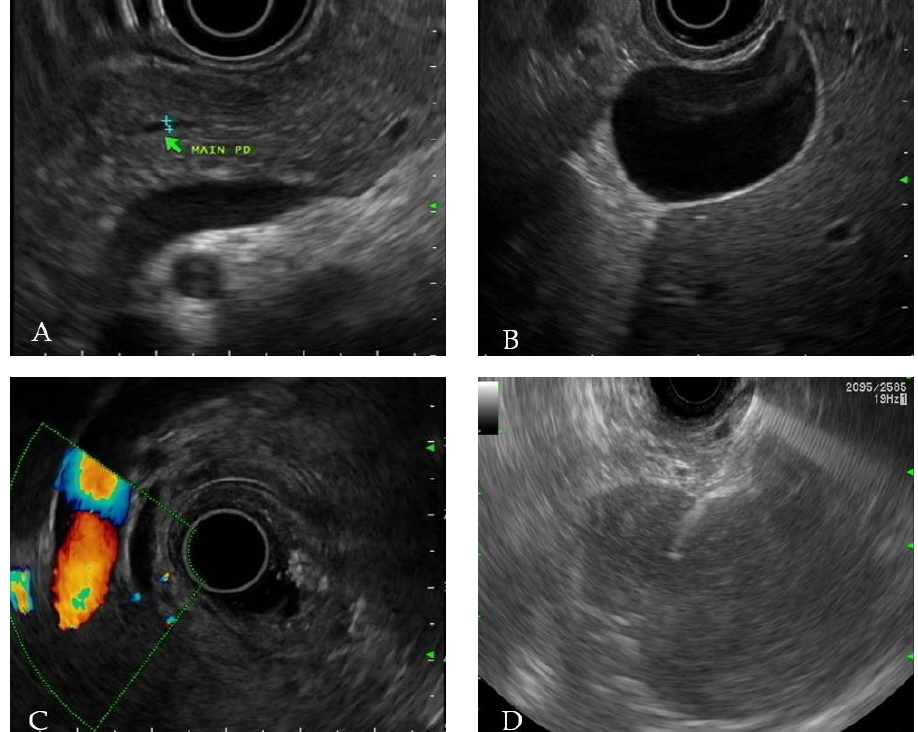
Figure 3. Endoscopic ultrasonography (EUS) findings. ( A ) Main pancreatic duct does not dilate with mild decreased echogenicity of pancreas parenchyma. ( B , C ) Observed gallbladder and common bile duct is unremarkable. ( D ) EUS-guided fine needle biopsy is performed at the tail of the pancreas. We observed microscopically that pancreas acinar cell structure was destroyed by diffusely infiltrated tumor cells (Figure 4A). These tumor cells were medium to large in their size, with irregular pleomorphic hyper-chromatin nuclei (Figure 4B). Tumor cells were strongly positive for cluster of differentiation (CD) 3 (Figure 4C) and CD 56 (Figure 4D) while negative for CD 20 (Figure 4E).